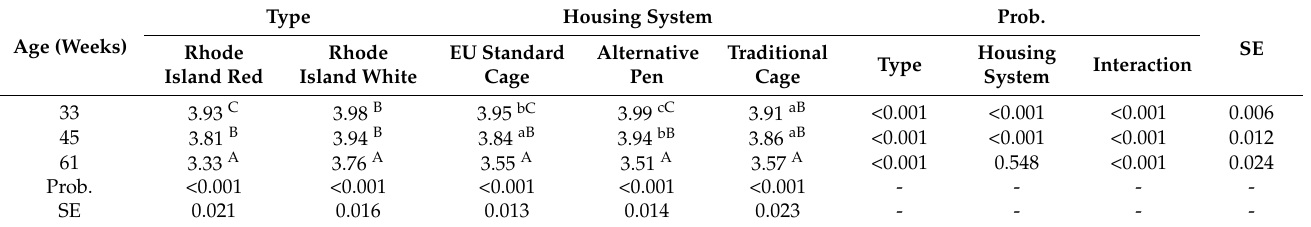
Table 4. Effect of type and housing system on the plumage points on the back feathers of non-beak- trimmed Rhode Island hens.